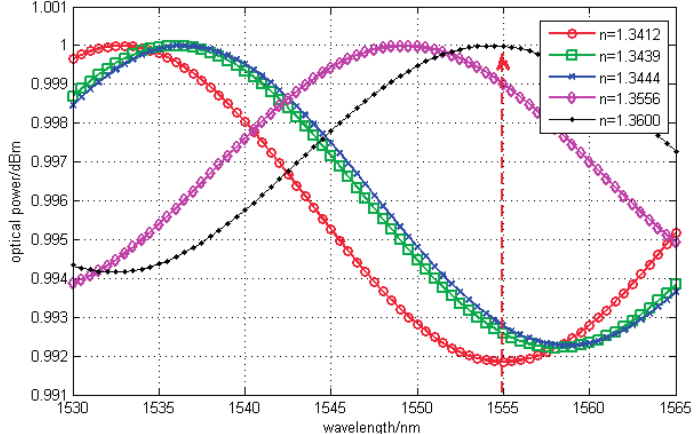
Figure 3. Signals of F-P interference with cavity length of 20 μ